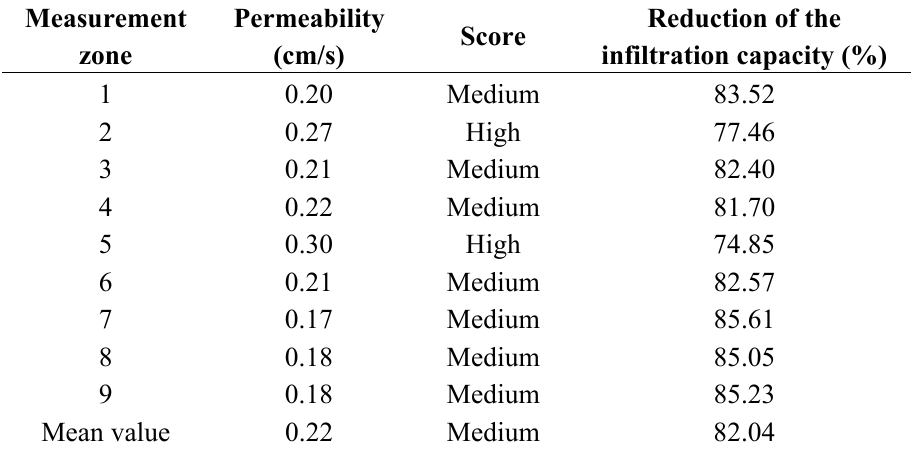
Table 3. Average permeability and reduction of the infiltration capacity values registered in each measurement zone within each Porous Asphalt (PA) surface car park and their corresponding score.